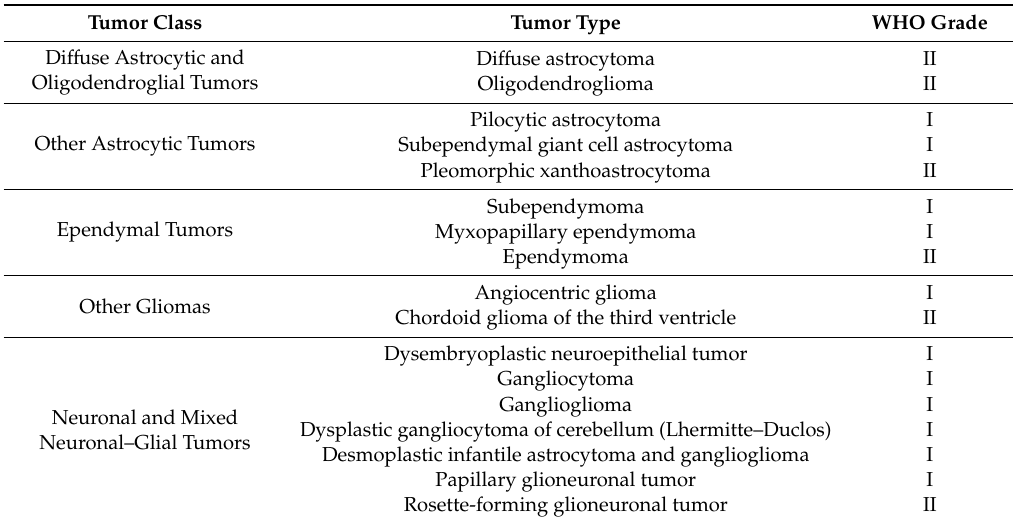
Table 1. Summary of WHO classification of low-grade gliomas (adapted from